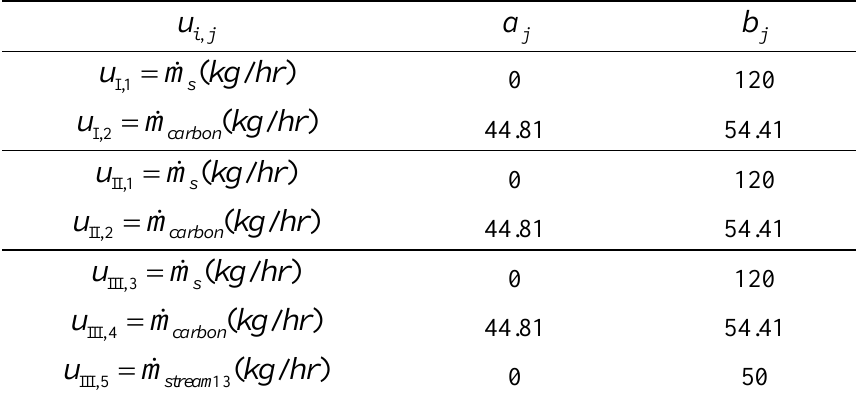
Table 6. Bounds of manipulated